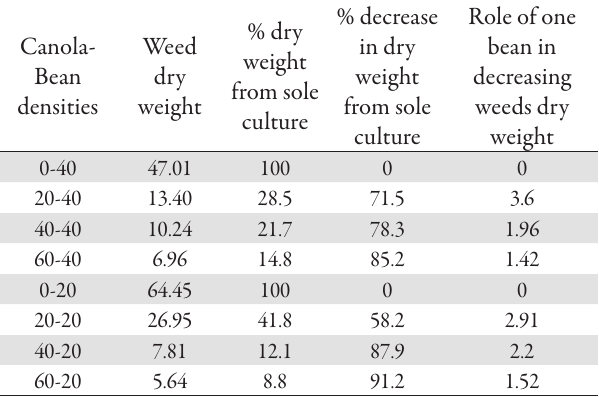
Tab. 3. Role of canola and faba bean in decreasing weed dry weight